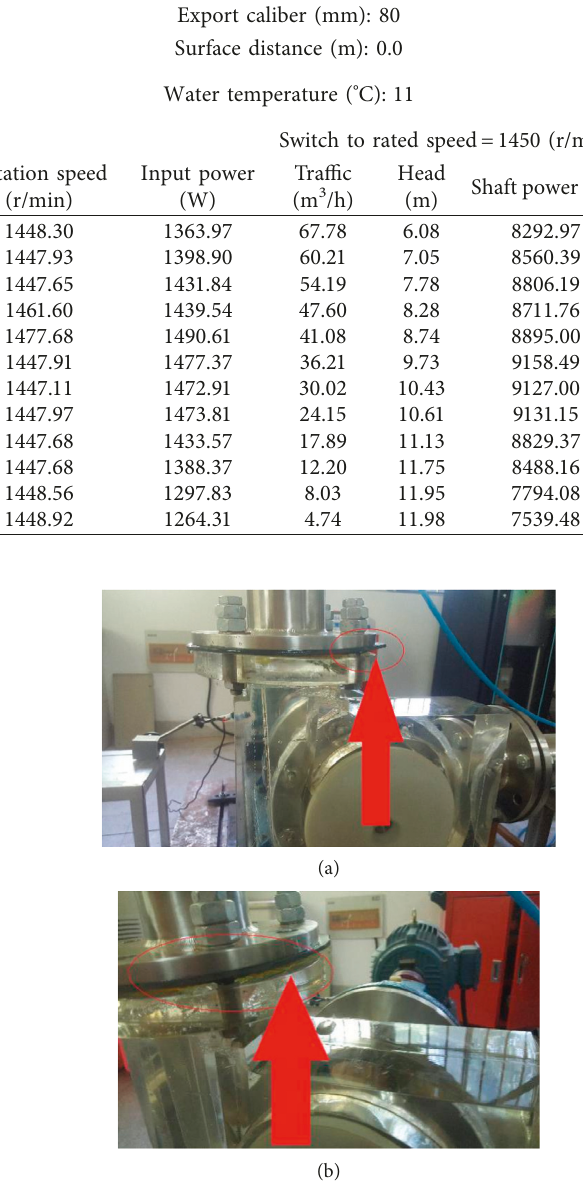
Figure 22: Warping position of water outlet pipe and pump shell